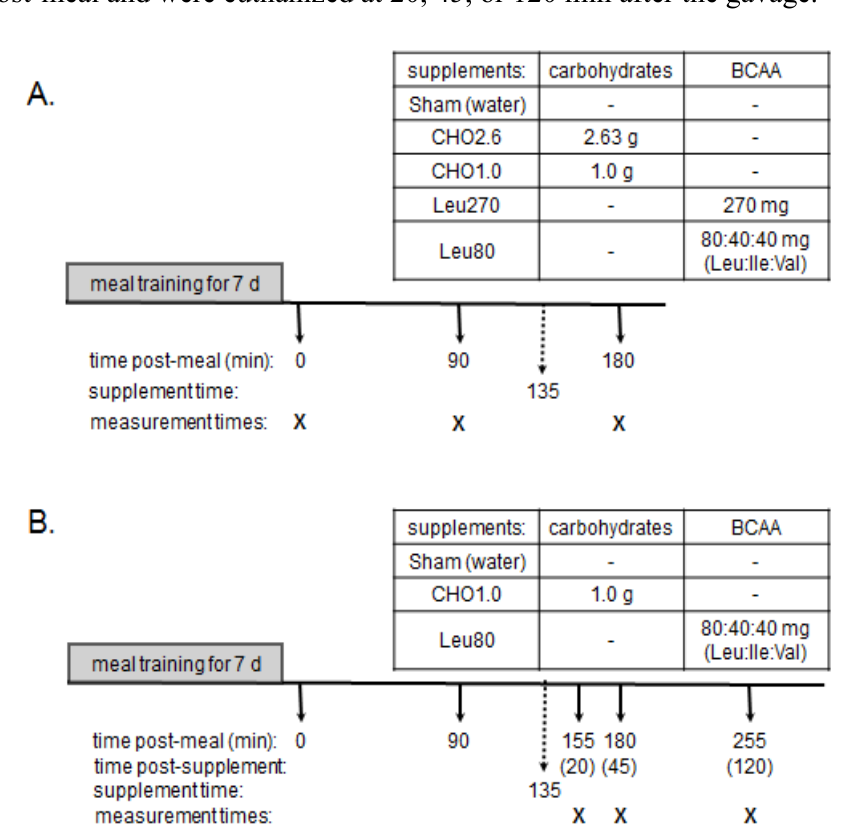
Figure 2. Study Design. Panel A and Panel B represent Experiments 1 and 2,